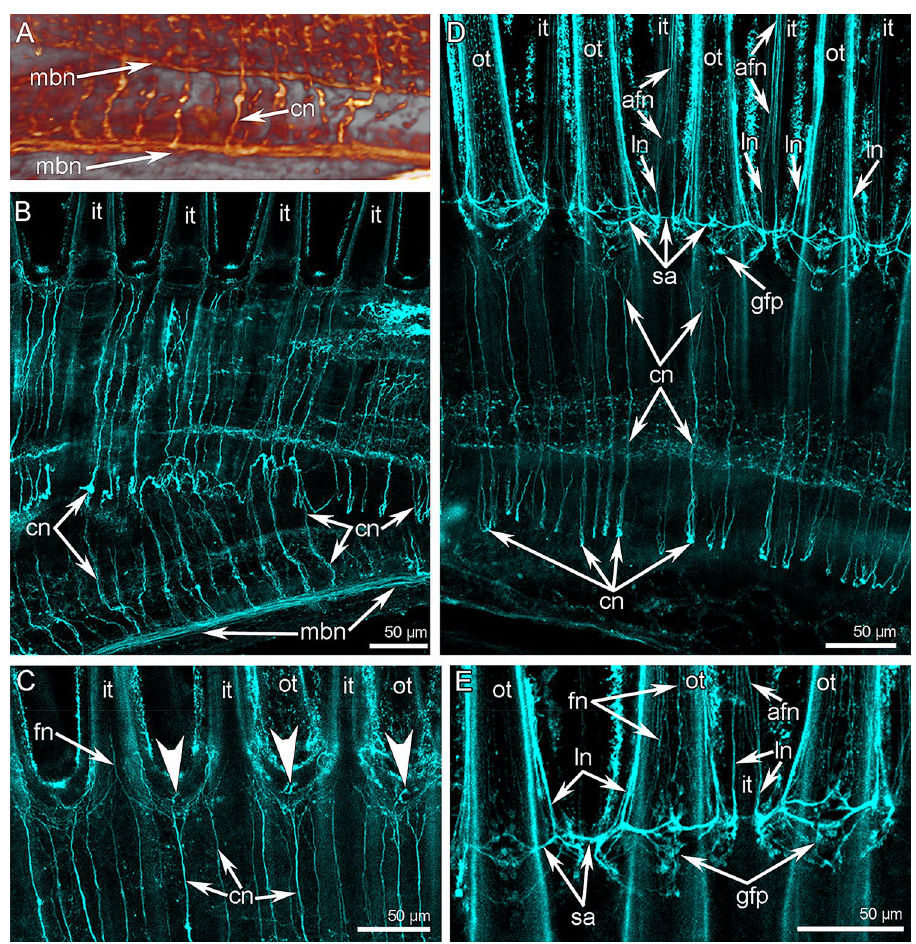
Figure 7. Details of innervation of the lateral arm in Coptothyris grayi . Volume rendering ( A ) and Z-projections ( B – E ) after immunostaining against acetylated alpha-tubulin (orange—in A and cyan in B – E ). ( A ) Two main brachial nerves and cross nerves emanating from them. ( B ) Main brachial nerve and curved cross nerves. ( C ) The most frontal side of the inner tentacles: cross nerves extend to the places between inner tentacles and give rise to two thick short nerves (arrowheads), which extend to the frontal side of the outer tentacles. ( D ) The most frontal side of outer tentacles: groups of perikarya at the base of each tentacle are evident. ( E ) Groups of frontal perikarya and second accessory brachial nerve. Abbreviations: afn—abfrontal tentacle nerve; cn— cross nerve; fn—frontal tentacle nerve; gfp—groups of frontal perikarya; it—inner tentacle; ln—lateral tentacle nerve; mbn—main brachial nerve; ot—outer tentacle; sa—second accessory brachial At the base of the tentacles, several cross nerves are grouped together in sites between the inner tentacles and give rise to two short, thick nerves, which extend between the bases of the inner tentacles to the frontal side of the outer tentacles (Fig. 7C). These short nerves are connected to the second accessory brachial nerve (Figs. 3B, 6, and 9A, D). This nerve is formed by a group of perikarya and neurites, which are located at the base of frontal side of the outer tentacles and which skirt these tentacles laterally (Figs. 7D, E and 9A, D). These frontal semicircles are connected to each other by bridges, which extend along bases on the abfrontal sides of the inner tentacles (Fig. 7D, E). The ultrastructure of the accessory brachial nerve is similar to that of the main brachial nerve. TEM revealed two types of perikarya in the accessory brachial nerve. One type (i.e., perikarya of the second type— pkII ), which has a lot in common with perikarya of the main brachial nerve, is the most abundant (Fig. 9A, D). They are large, have electron-light cytoplasm, and contain a large nucleus that lacks a nucleolus (Fig. 10A). Their cytoplasm is filled with numerous Golgi apparatuses and vesicles with electron-lucent content (Fig. 10B). The perikarya of the other type (i.e., perikarya of the third type— pkIII ) are located at the base of the epithelium and are not abundant (Fig. 9A). These perikarya have electron-dense cytoplasm and contain vesicles with electron-dense content (Fig. 10A). A specific feature of these perikarya is the presence of two centrioles. The third large brachial nerve is the lower brachial nerve (Figs. 2B, 3A, and 6). It extends along both outer sides of each brachial arm and extends about 350 µm from the tentacle base (Fig. 11A). The lower brachial nerve is formed by a thick aggregation of perikarya and their projections (Figs. 10C and 11C). The large cluster of neurites is penetrated by long and thin basal projection of supportive cells (= radial glia cells) (Fig. 10C). The lower brachial nerve is associated with many perikarya, which form long projections that